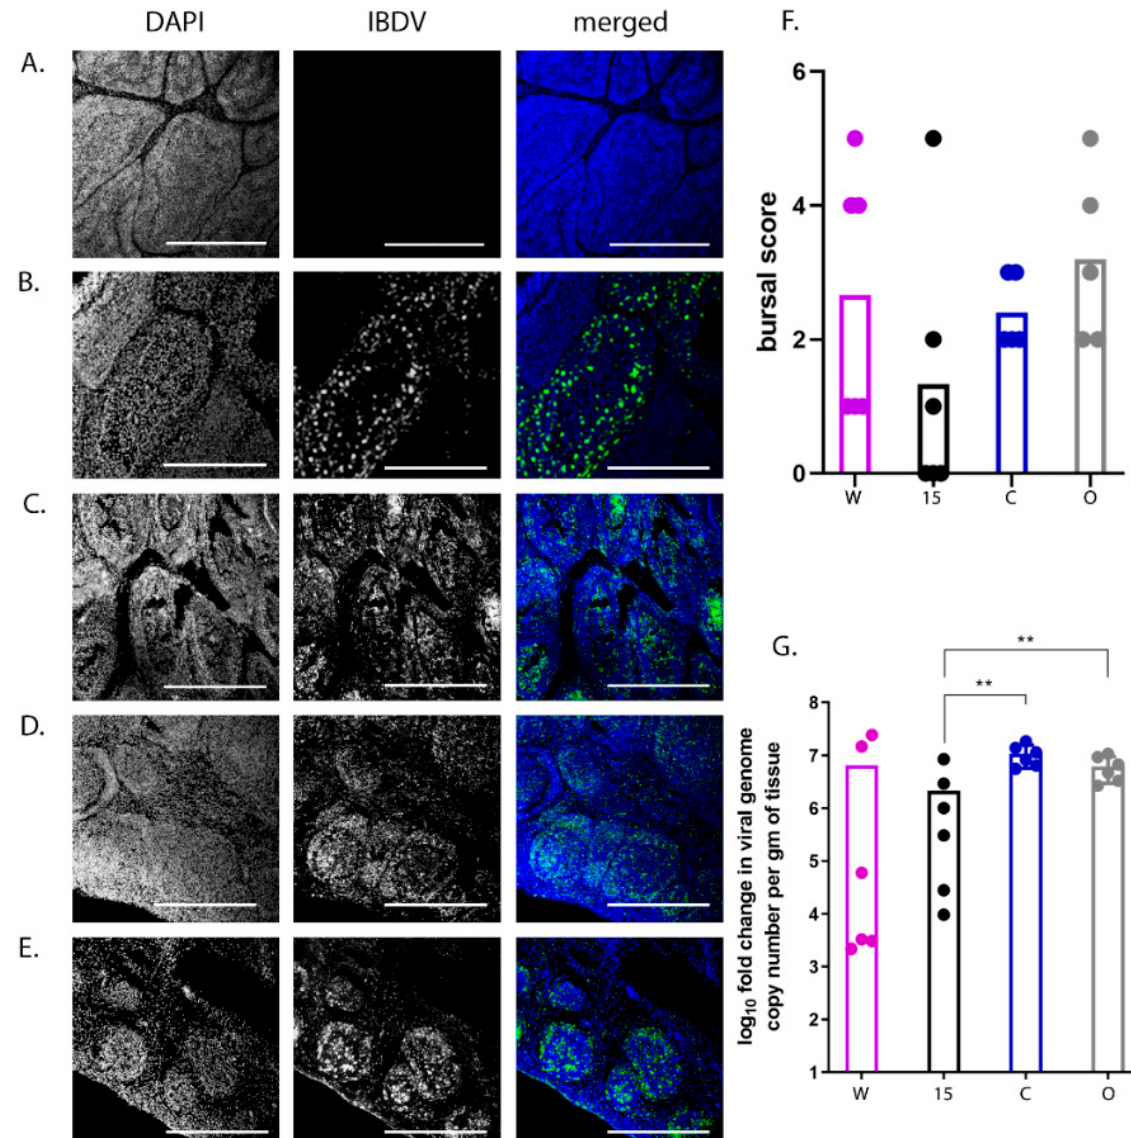
Figure 3. Line 15 had less histopathology and lower levels of viral replication than other lines in the study. Bursal samples were harvested from birds at 3 dpi, frozen in tissue freezing medium and cryo-sectioned. Tissue sections were stained with a mouse anti-IBDV VP3 monoclonal IgG antibody and a goat-anti-mouse IgG secondary antibody conjugated to AlexaFluor 488 (green) and cell nuclei were stained with DAPI (blue) and imaged by confocal microscopy. Scale bars represent 250 μ m ( A – E ). Sections were imaged from mock-inoculated and UK661 infected line W birds ( A , B ), and UK661 infected line 15 ( C ), line C ( D ) and line O ( E ) birds. The extent of damage to each BF was scored according to published protocols [19]. The lesion scores of the images were 0, 4, 5, 2 and 5, respectively. BF lesion scores were plotted for birds of line W, 15, C and O. Each dot represents one bird and each bar represents the average for the indicated line ( F ). RNA was extracted from the BF samples, reverse transcribed to cDNA, and amplified by qPCR using primers specific to a virus gene (VP2) and a housekeeping gene (RPLPO). The fold change in viral RNA was determined for each bird, normalised to RPLPO, and expressed per g of BF tissue relative to mock infected control samples in a ∆∆ CT analysis.The Log 10 fold change of viral VP2 copy number per g of BF tissue was plotted for birds of line W, 15, C and O ( G ). Each dot represents one bird and each bar represents the average for the indicated line. Data passed Shapiro–Wilk normality tests before being analysed by one-way ANOVA and Tukey’s multiple comparison tests (** p <